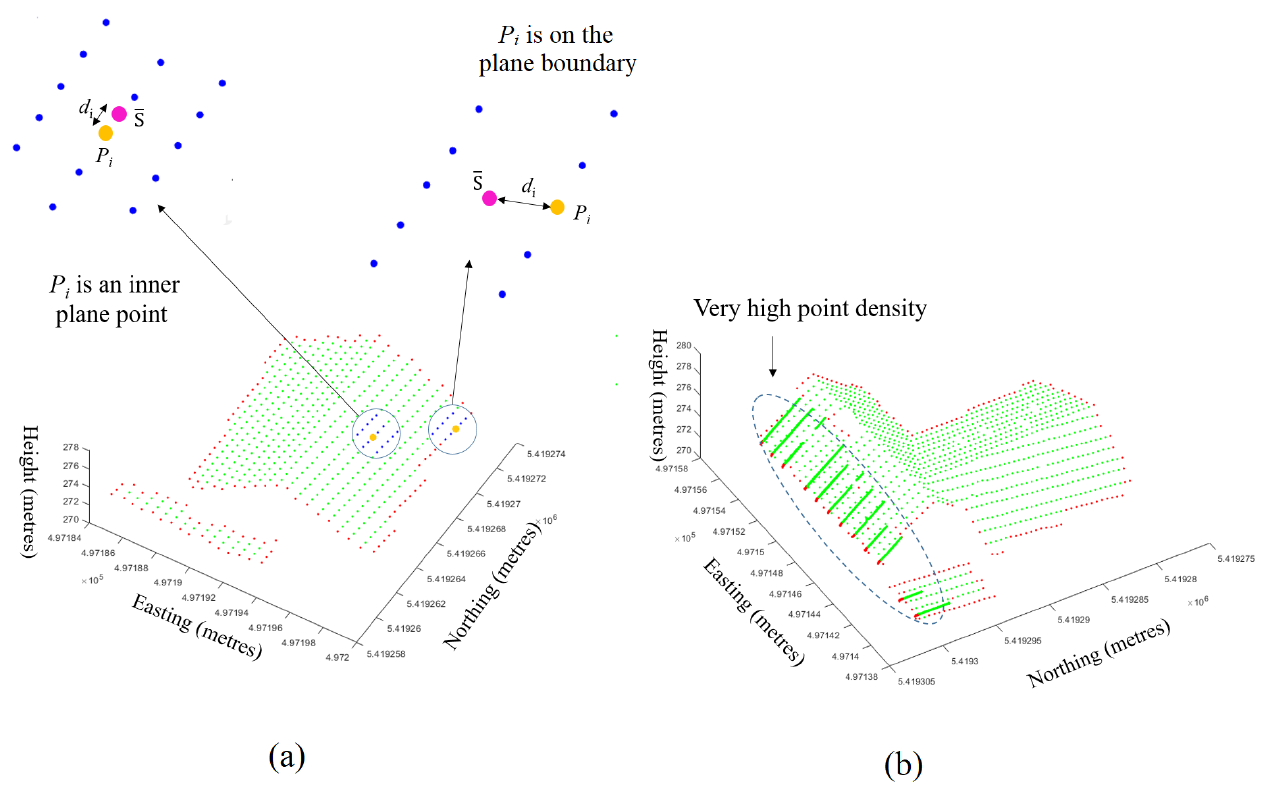
Figure 7. Boundary point detection examples with ( a ) the usual point density on all planes and ( b ) the unexpectedly very high point density on some planes. In the magnified images of ( a ), d i indicates the distance between P i and the mean ¯S of the neighbours S p